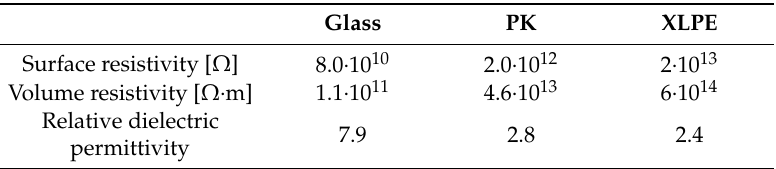
Table 2. Electrical properties of materials in specimens.